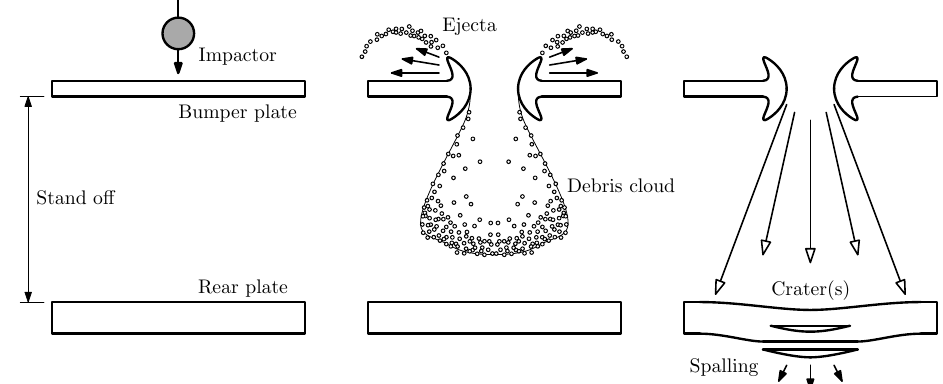
Figure 1. Conventional Whipple shield design: ( left ) Whipple shield configuration, ( centre ) post- impact debris cloud formation and ( right ) effects of impact on rear plate (adapted from [5]).